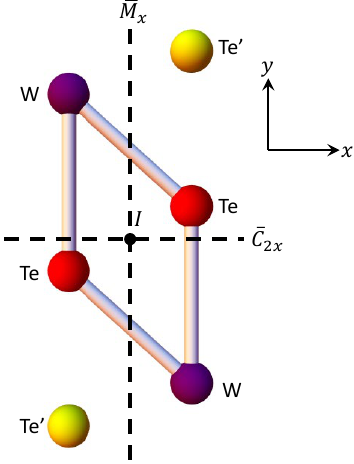
Figure 1: (Color online) The unit cell of monolayer WTe purple tungsten, W, sites, and p -orbitals centered at red tellurium, Te, cites, give rise to the low-energy bands near the Fermi level. The orbitals of the yellow Te (cid:48) sites do not participate in the low-energy physics. Also shown are the glide plane ¯ M the screw axis ¯ C that run through the inversion center I 2 x